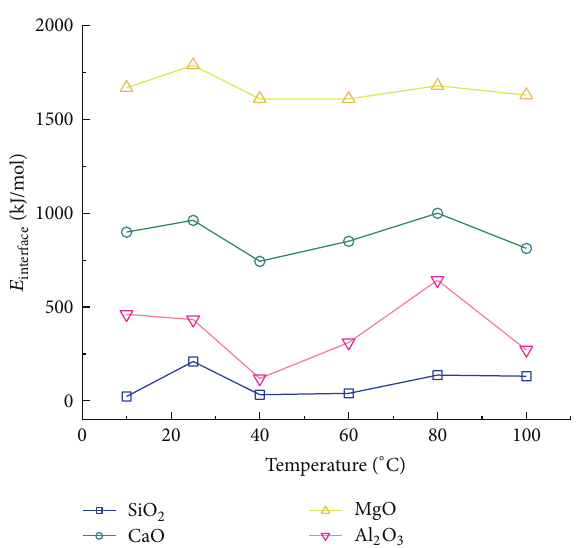
Figure 16: The interfacial energy with different temperature.